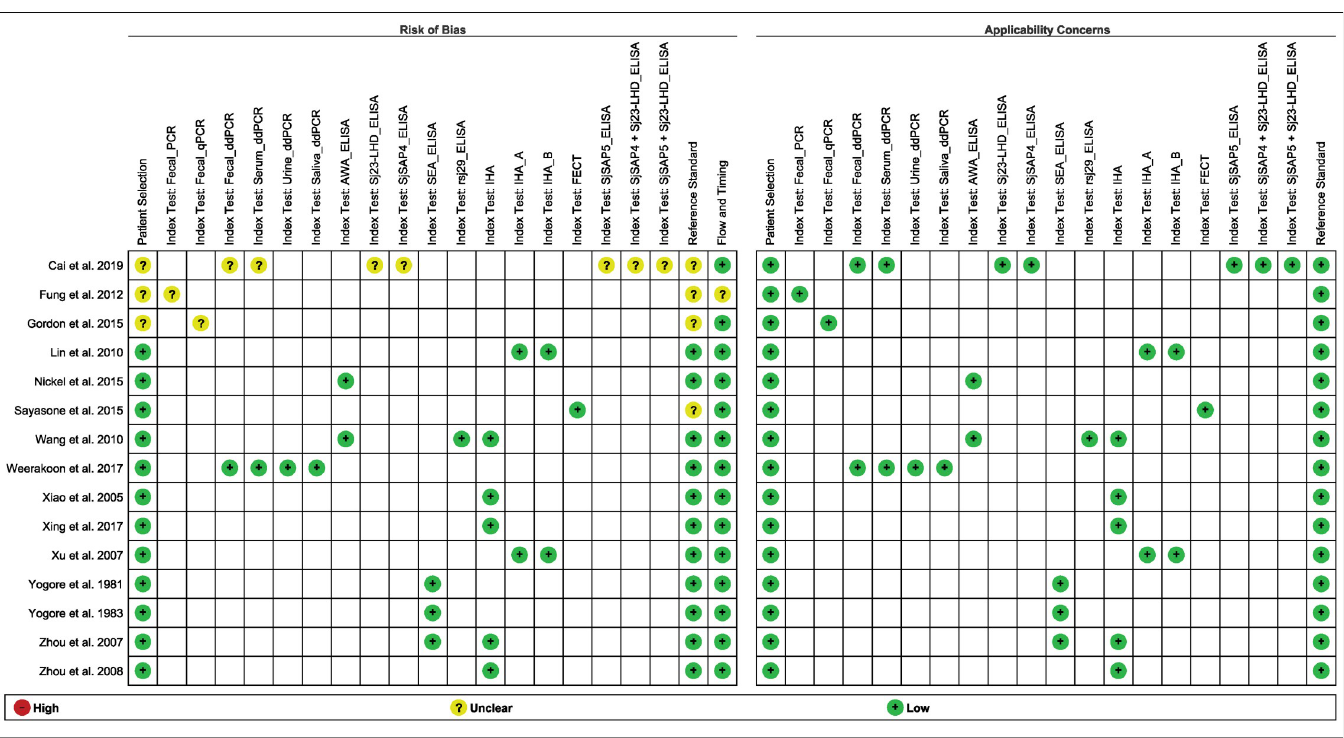
Fig 9. Risk of bias and applicability concerns summary for each domain of the included studies. Note: Blank cell represents the study not reported respective index test.